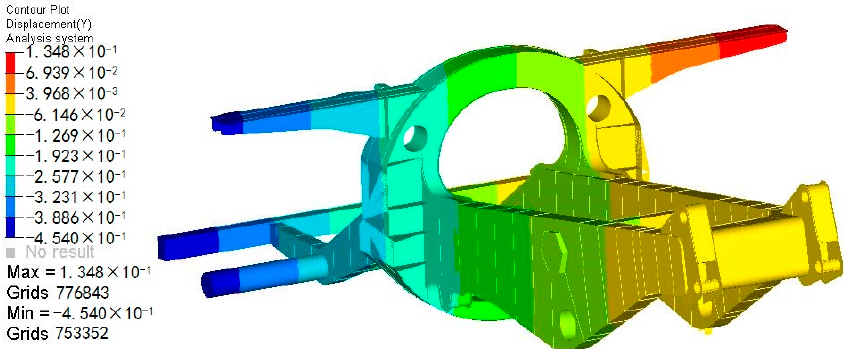
Figure 10. Contour of displacement in vertical direction under torsion (unit: m).